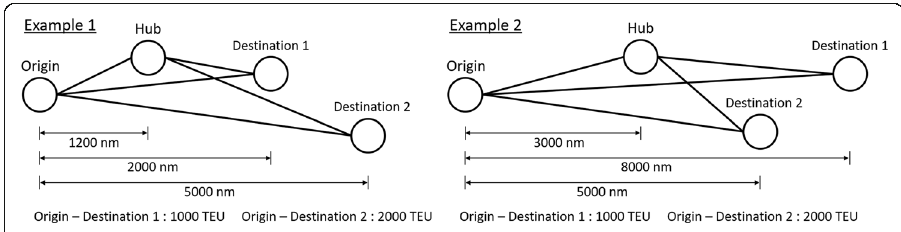
Fig. 1 Examples based on a virtual maritime